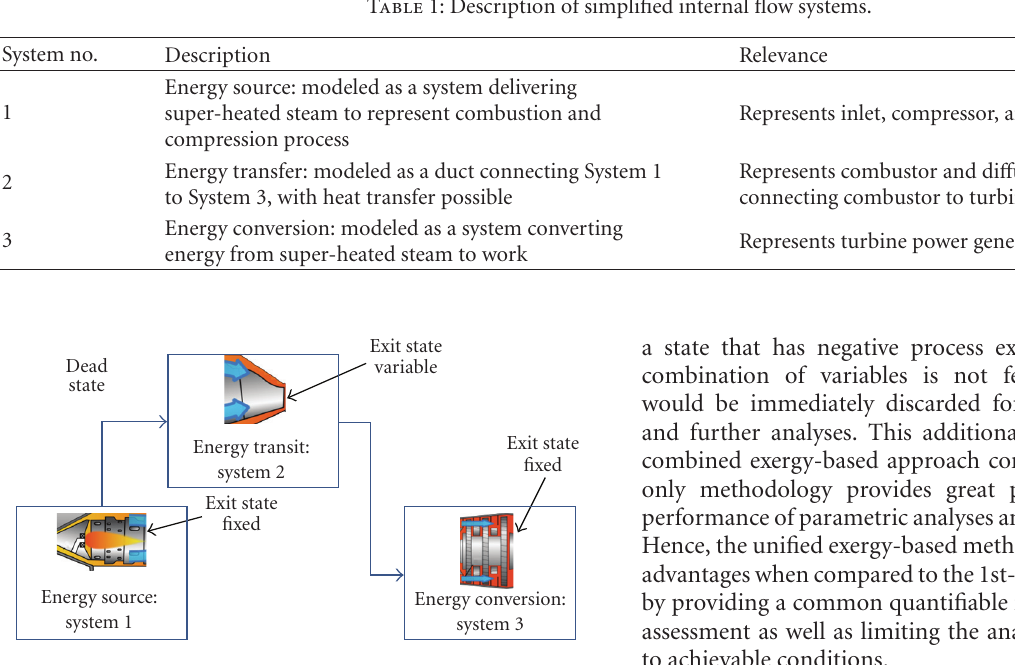
Figure 2: Sketch of simplified internal flow system that represents a more complex system component of a turbojet engine.